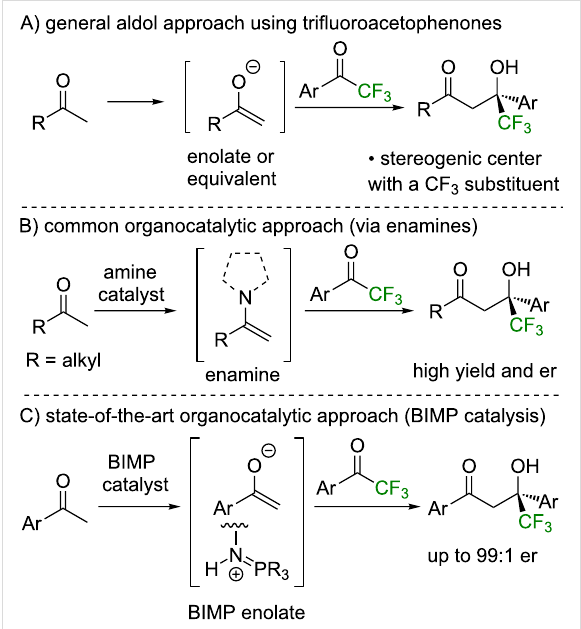
Figure 1: Organocatalytic enantioselective aldol approaches using trifluoroacetophenone